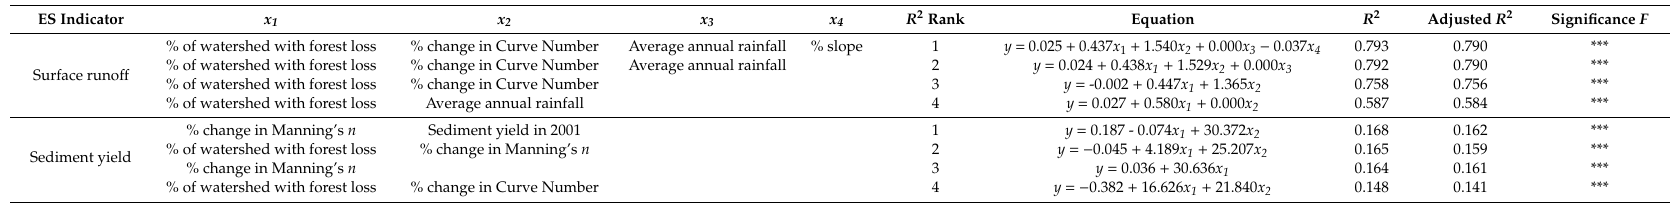
Table 3. Results of multiple regression analysis for surface runo ff and sediment yield. Variables for the regressions with the highest four R 2 values are shown. The number of observations was 268 (equal to the number of SWAT-created sub-basins) for all regressions. The *** for significance F implies values are <